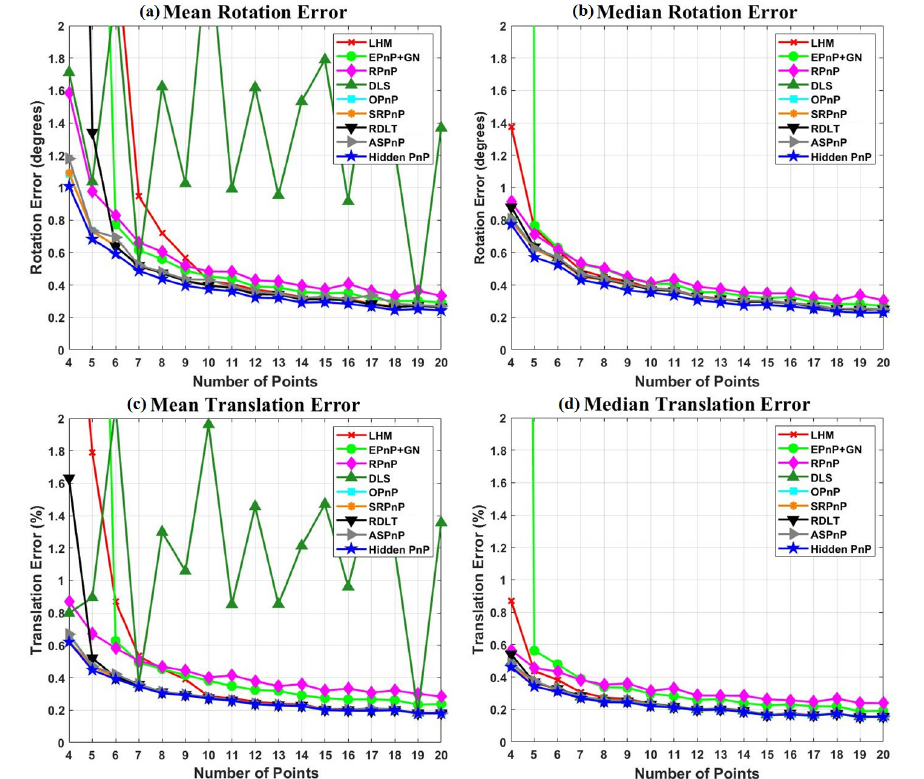
Figure 3. Error comparison in the Ordinary 3D case.